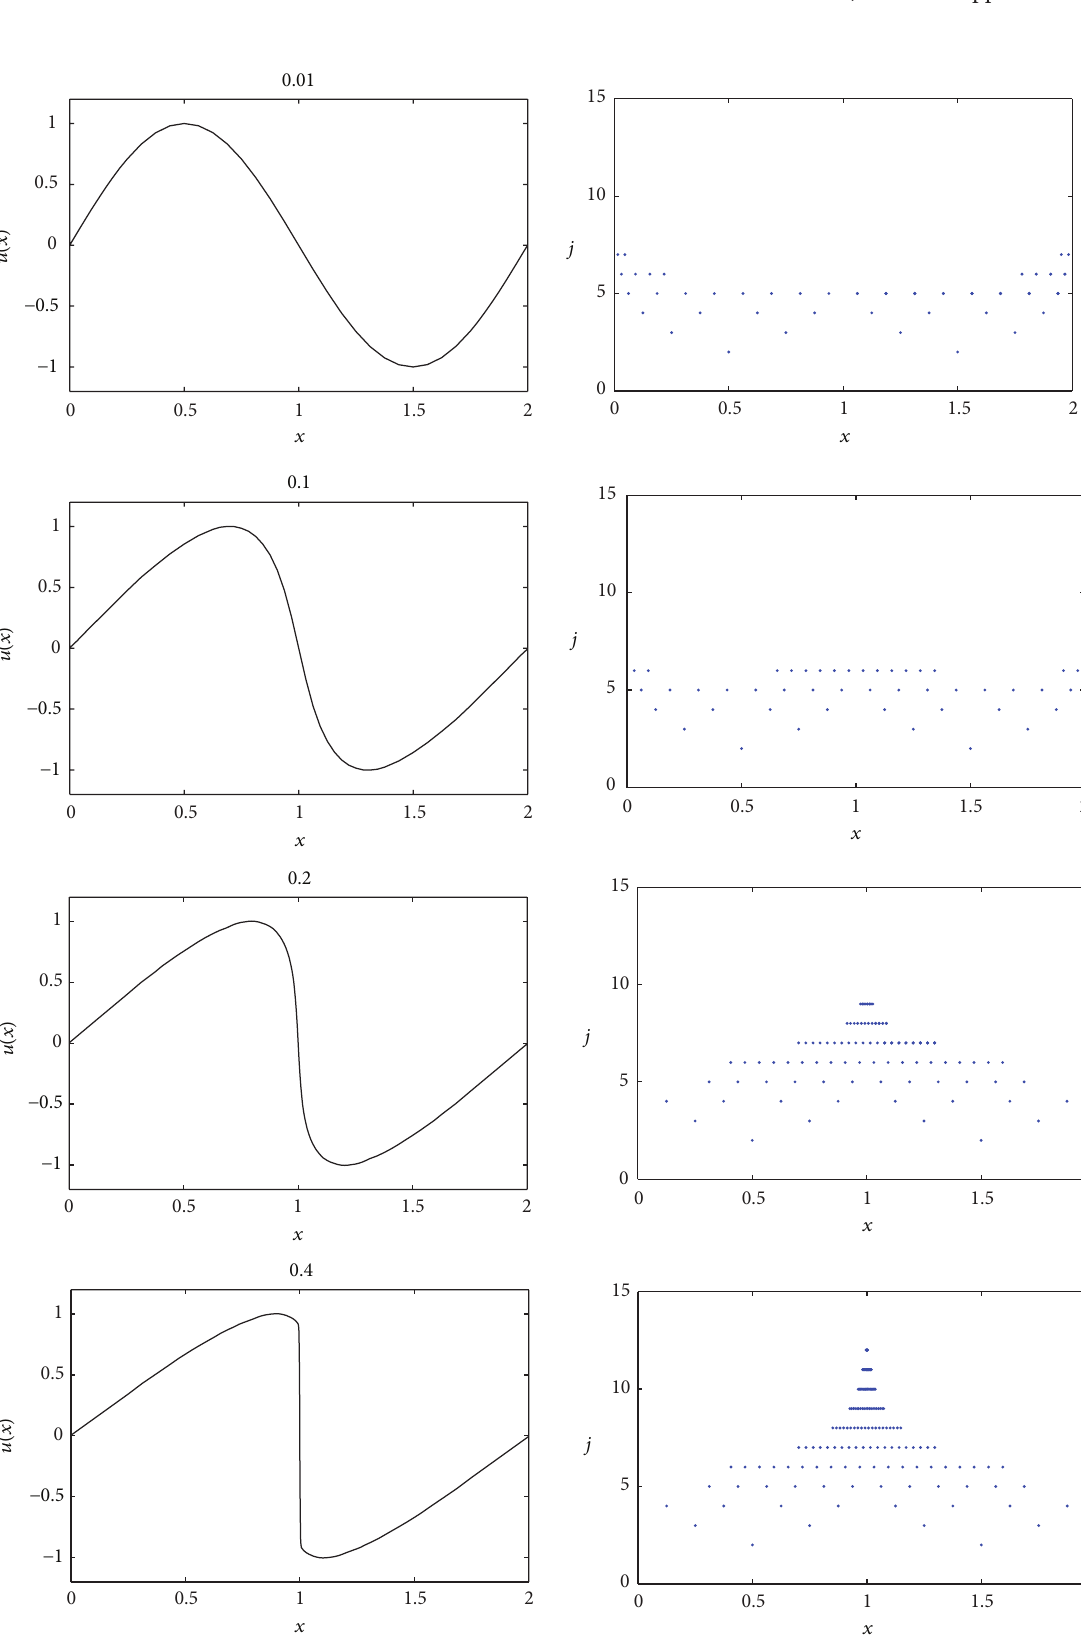
Figure 2: Evolution of the solution and collocation points for the solution of the Burgers equation with HAM-based